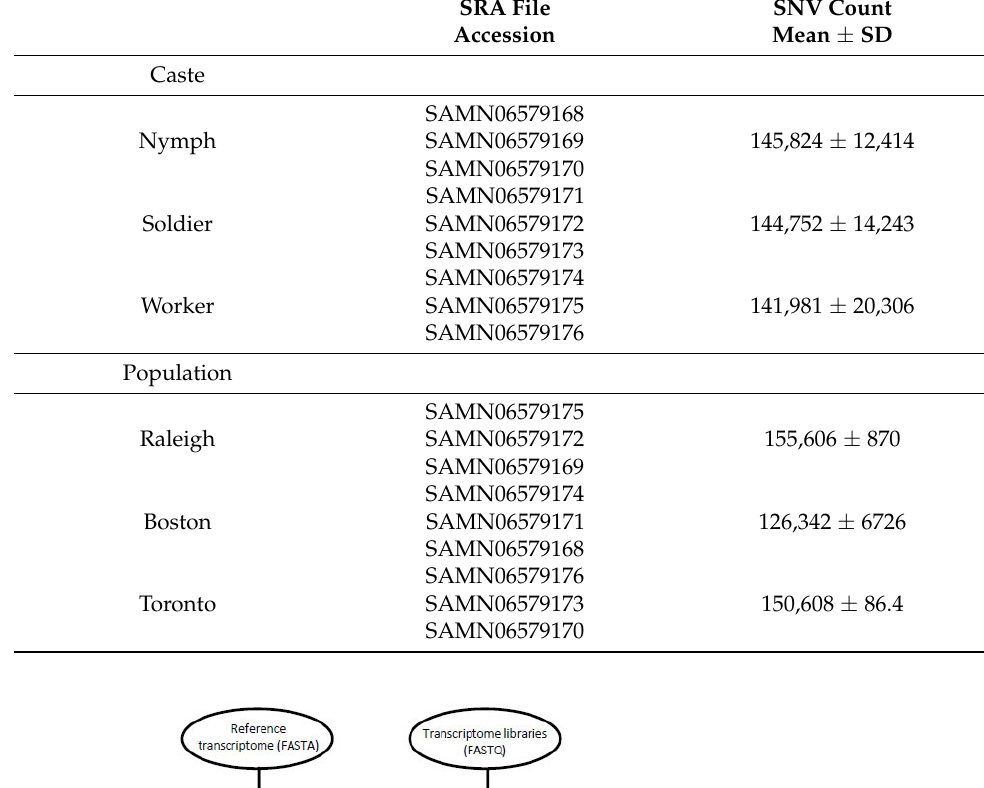
Table 1. Summary statistics for Reticulitermes flavipes SNV count by population and caste.